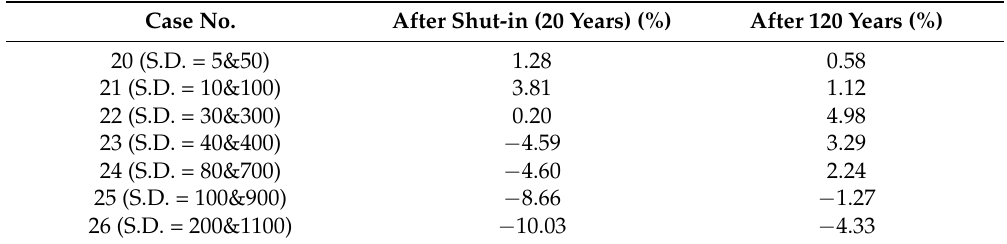
Table 5. Data of increase/decrease of CO 2 dissolution in brine with changing standard deviation. Case